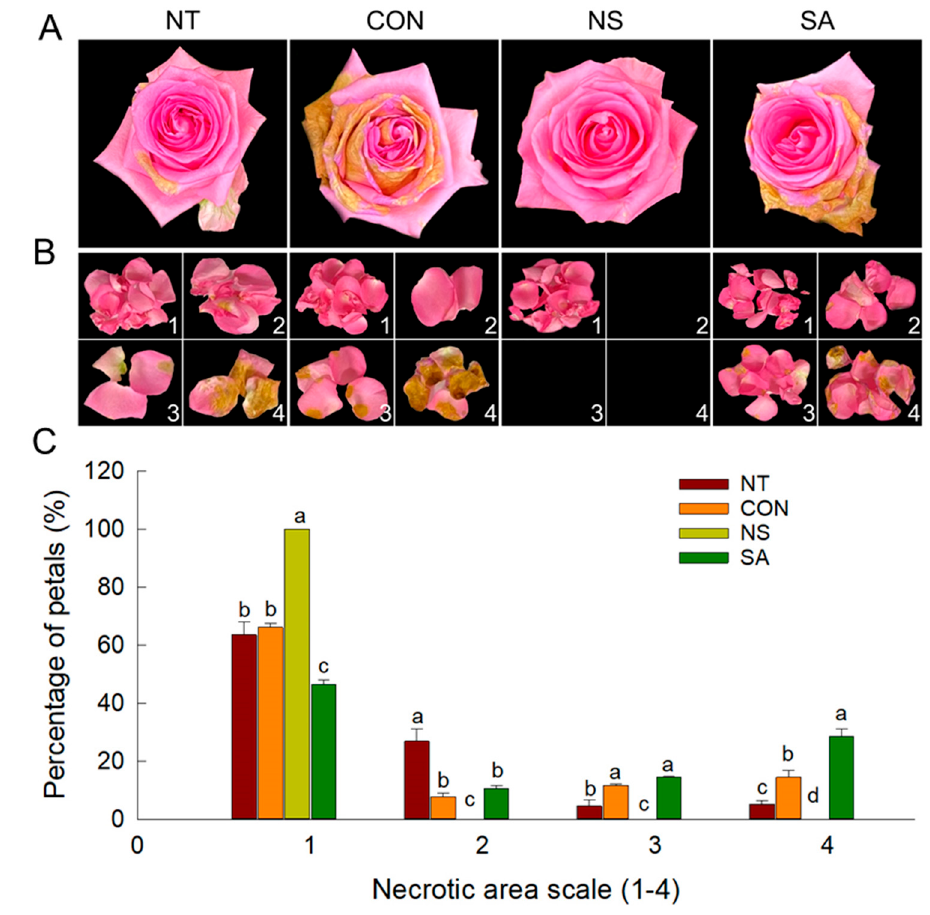
Figure 1. Effect of B. cinerea infection on visual appearance ( A ) and the B. cinerea infection rate in petals ( B , C ) of cut roses on day 7 after the transport simulation. Scale of the extent of the infected rose petal area by B. cinerea : 1, no infection; 2, ≤ 25%; 3, 26–50%; and 4, 51–100%. NT, non-treated flowers; CON, flowers were held in distilled water; NS and SA, cut flowers were treated with nano silver and salicylic acid. CON, NS, and SA flowers were sprayed with B. cinerea conidial suspension to induce gray mold development. All flowers were then stored at 10 ± 2 ◦ C and 80–90% RH in dark conditions for 4 d for export simulation. Different letters above bars indicate statistically significant differences among treatments at p = 0.05 based on Duncan’s multiple range test. Vertical bars show standard errors of the means ( n = 9).